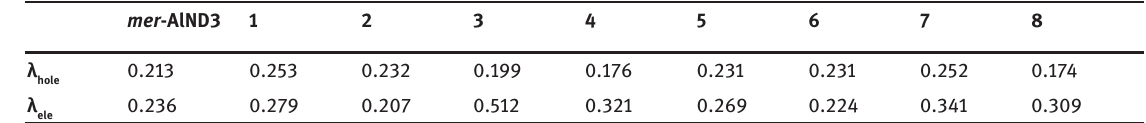
) and electron (λ ) at B3LYP/6-31G(D) level. hole ele